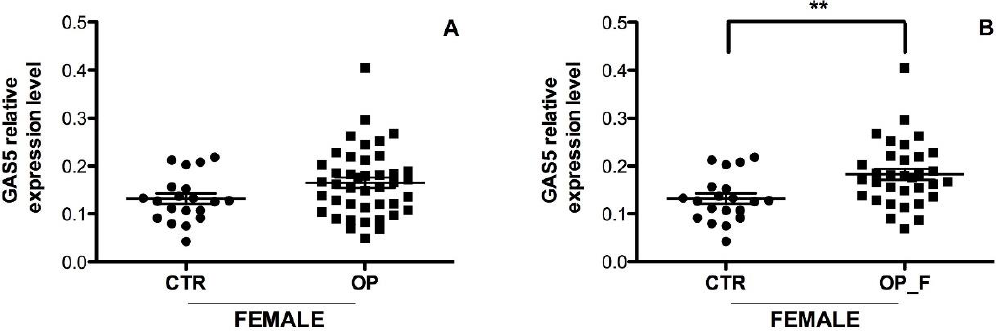
Figure 5. Serum expression level of GAS5 in OP female patients. ( A ) GAS5 expression level was analyzed from serum of 42 OP females, with and without fragility fractures, and 20 healthy females. NS; ( B ) GAS5 expression level was analyzed in the serum from 33 OP fractured females and 20 healthy females. GAPDH mRNA level was used to normalize the relative amount of GAS5 and relative expression values are expressed as 2 −ΔCt . Individual data points represent the mean of duplicate assays for each sample. Statistical differences between groups were analyzed for significance using unpaired Student’s t -test. Error bars indicate mean ± s.e.m. ** p < 0.01.